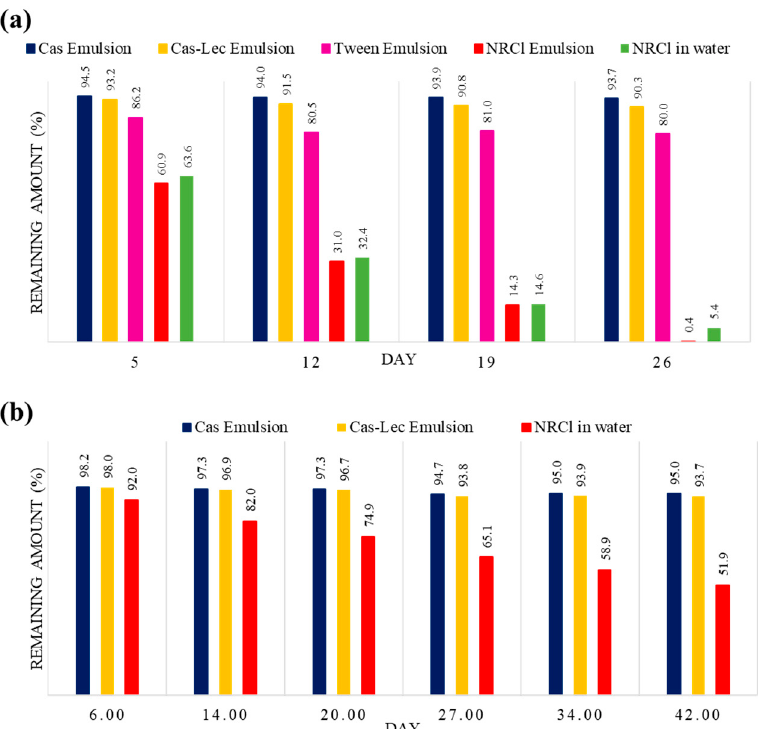
Figure 3. ( a ) Comparison of hydrolysis stability of NRTOCl emulsions with NRCl at 35 °C; ( b ) com- parison of hydrolysis stability of NRTOCl in emulsions with NRCl at 25 °C.